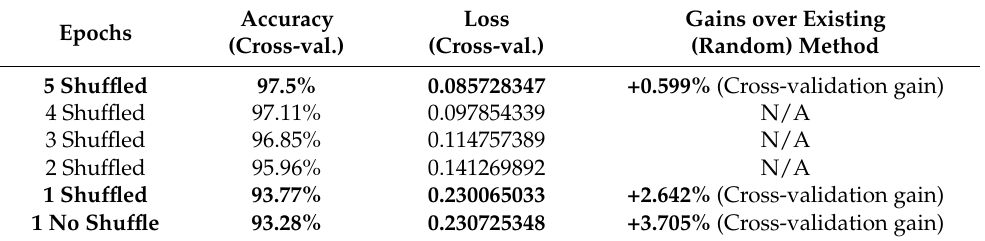
Table 2. Gains of the proposed non-random initialization method over the existing benchmark. Accuracy Loss Gains over Existing Epochs (Cross-val.) (Cross-val.) (Random)